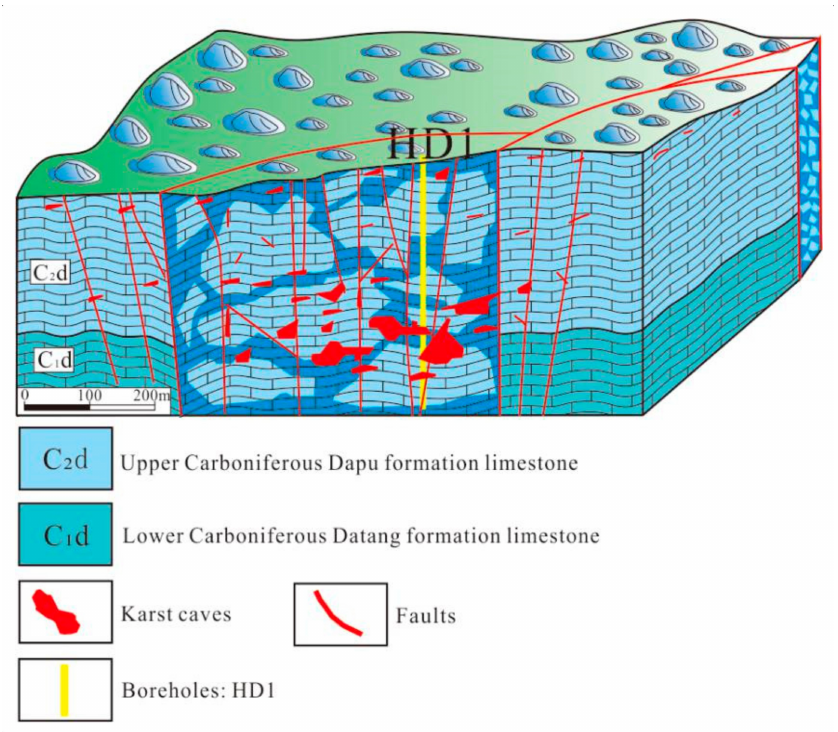
Figure 11. Spatial interpretation of deep karst controlled by faults in Huanjiang syncline HD1 well.